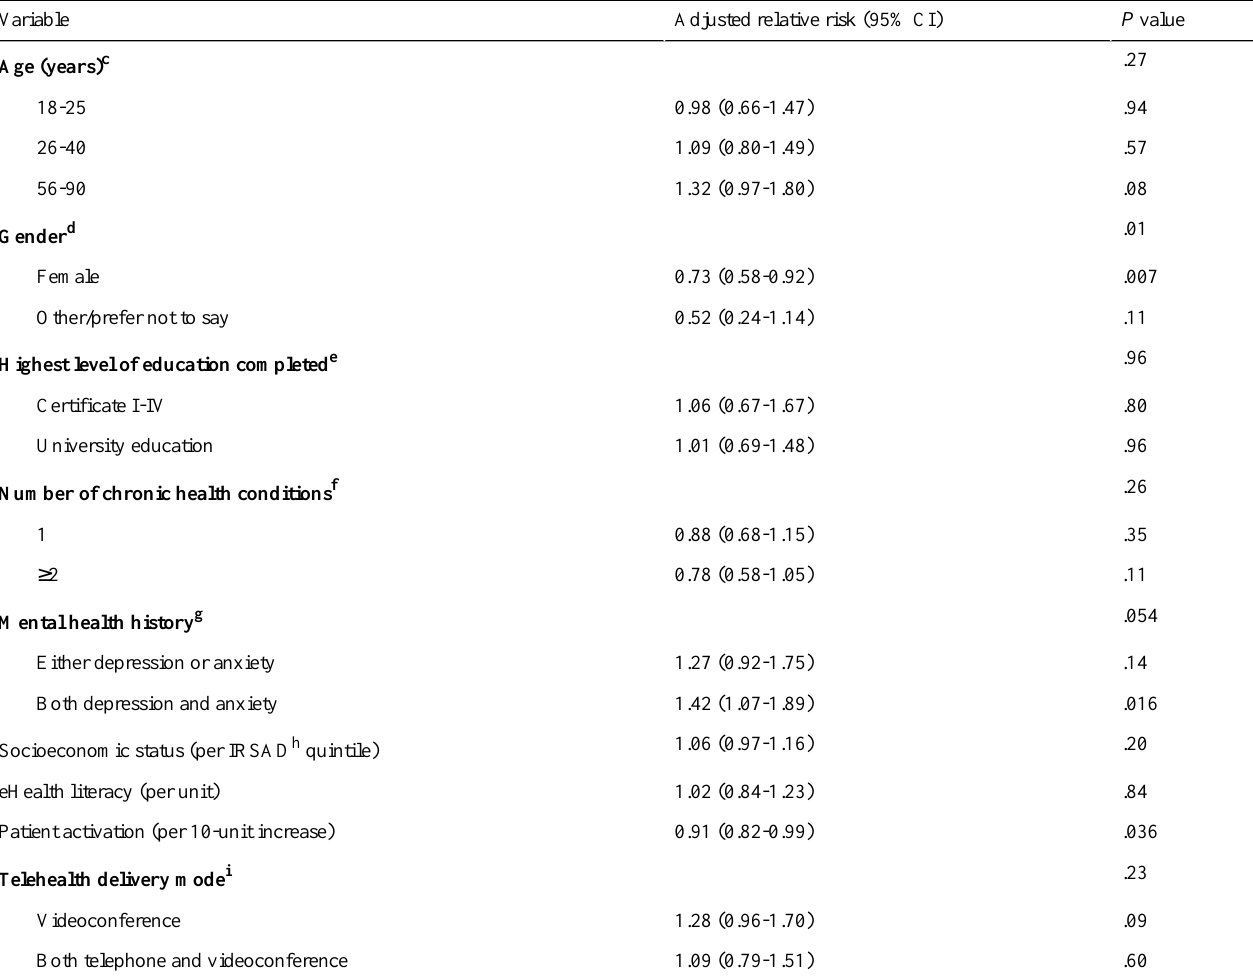
Table 3. Multivariable a analysis of factors associated with a poorer b telehealth experience than an in-person appointment experience (n=574). Adjusted relative risks of <1 indicate a reduced risk of reporting a poorer telehealth experience relative to the reference